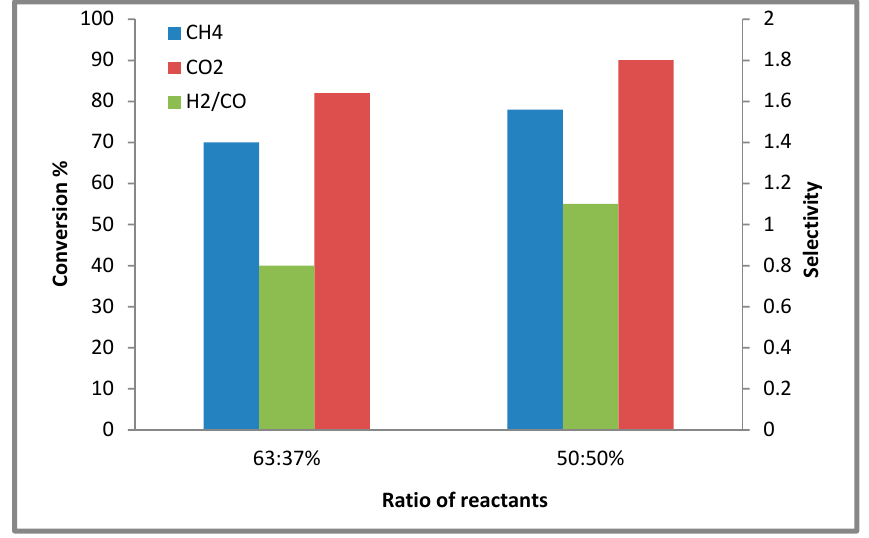
Figure 8. Changing the reactant CH 4 :CO 2 ratio concentration 1–2:1 2–1:1 over the conversion percentage and H 2 /CO ratio for Ni,Pd,Pt/Mg 0.85 Ce 4+0.15 O catalyst at 900 °C, with GHSV=15000 mL h − 1 g − 1 cat.